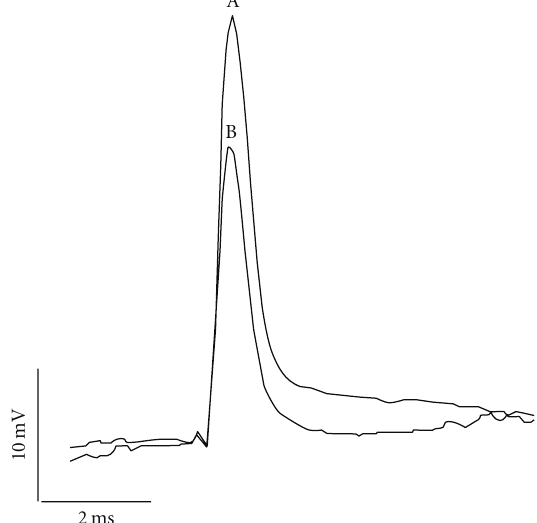
Figure 2: E ff ect of NST on nerve compound action potential (CAP). The figure shows representative superimposed CAP record- ings, in the absence (control, A) and 30 min after the addition of NST (3.57mM) (B).